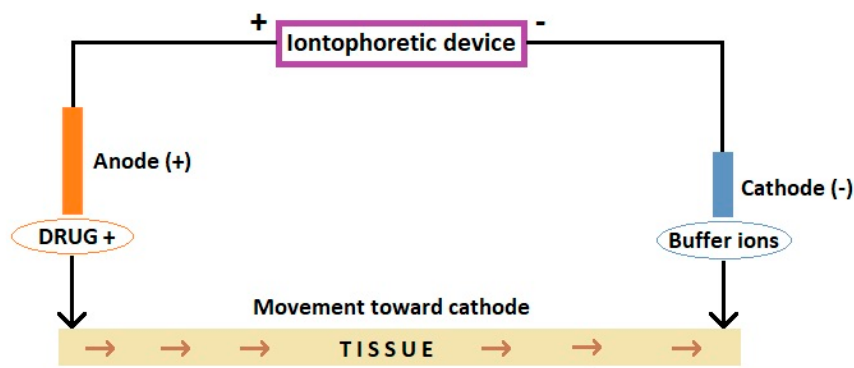
Figure 1. Scheme of iontophoretic device. Based on Dhote et al. [2], and Wanasathop and Li [7].